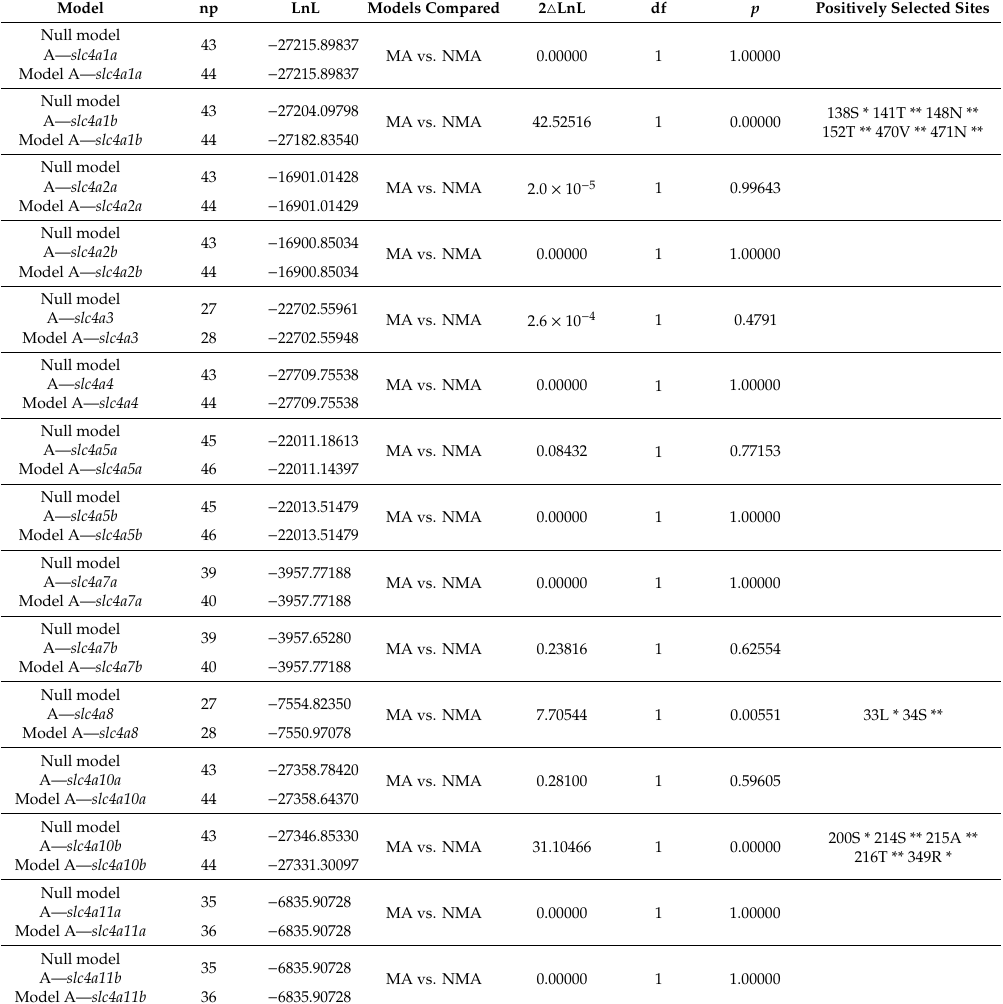
Table 2. The parameters and statistical significances of likelihood ratio tests for the branch-site models. Model np LnL Models